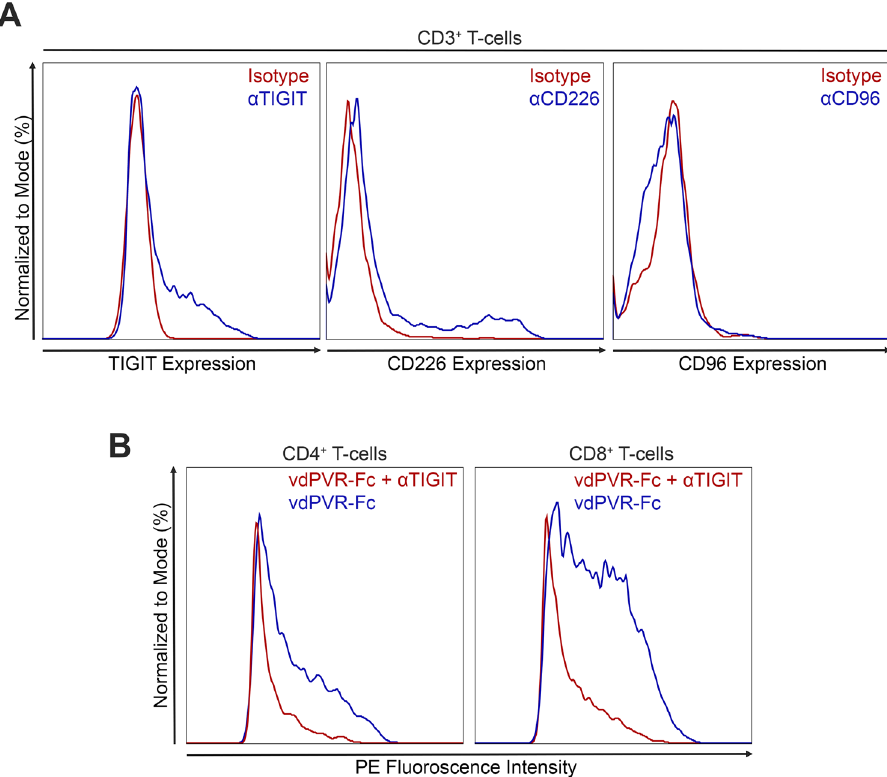
Figure 5. Expression of PVR cognate receptors on T-cells and cell binding competition. (A) TIGIT, CD226 and CD96 expression on CD3 + T-cells was assessed after 1 day of stimulation with anti-CD3/CD28 beads. (B) Flow cytometry histograms showing vdPVR-Fc binding to stimulated CD4 + and CD8 + T-cell subsets (blue) and vdPVR-Fc binding after the addition of 2-molar excess anti-TIGIT antibody (red). Data are representative of 2 independent